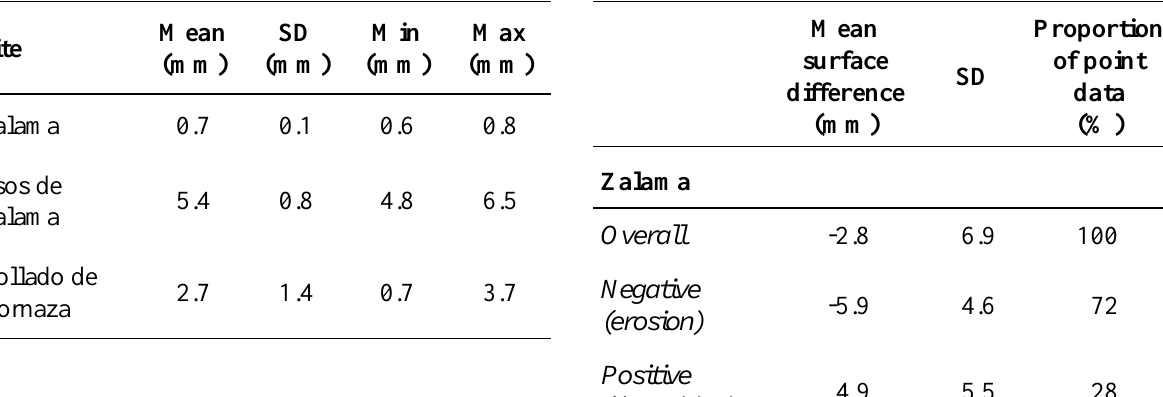
Table 3. Accuracy of point cloud registration. Table 4. Mean surface difference for all study